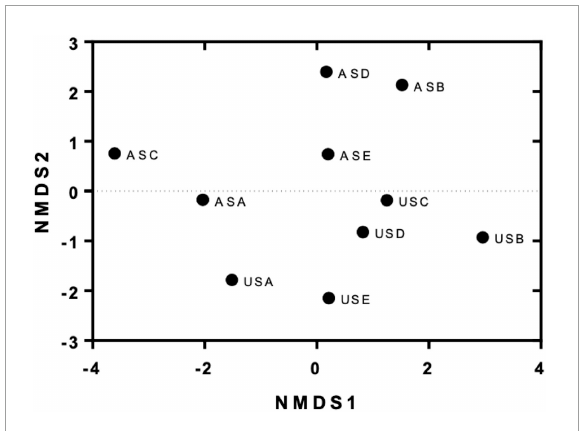
FIGURE5 Non-metric multidimensional scaling (NMDS) of obtained transconjugants from conjugation experiments in the absence and presence of metals. The results show the ordination of different groups of transconjugants in two dimensions according to the similarities in their MDRPs. US: transconjugants were obtained using the urban site as the donor source. AS: Transconjugants were obtained using the agricultural site as the donor source. Treatments: A = without the addition of metals, B and C = 0.5 and 1 mM ZnSO4, respectively, D and E = 0.5 and 1 mM CuSO4,